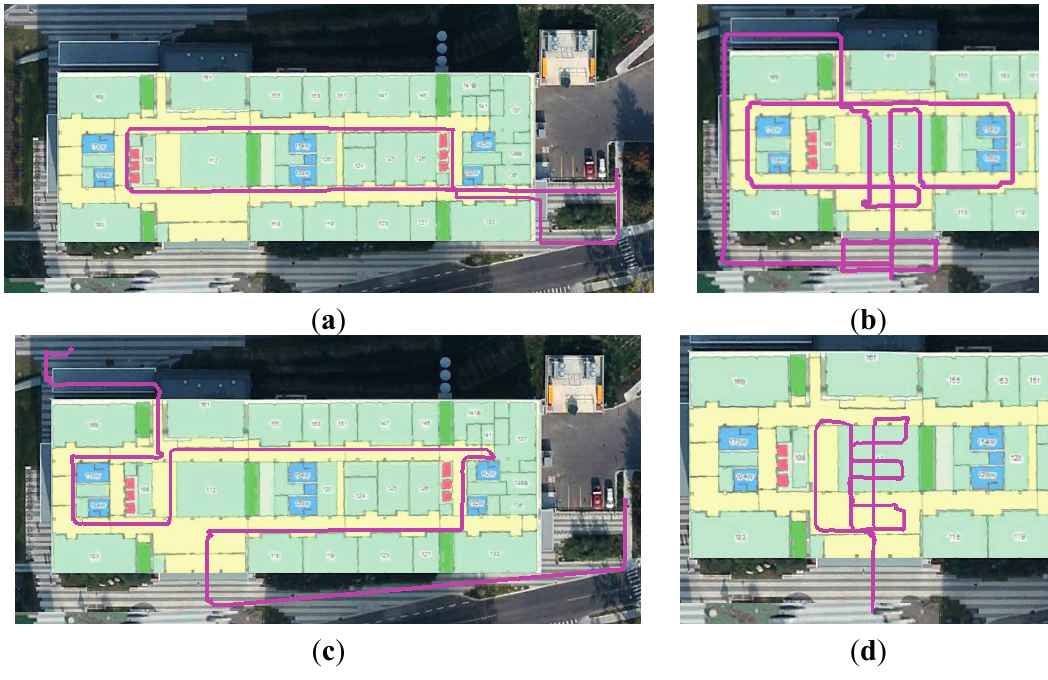
Figure 4. Different trajectories used to generate WiFi DB ( a ) Trajectory 1; ( b ) Trajectory 2; ( c ) Trajectory 3; ( d ) Trajectory